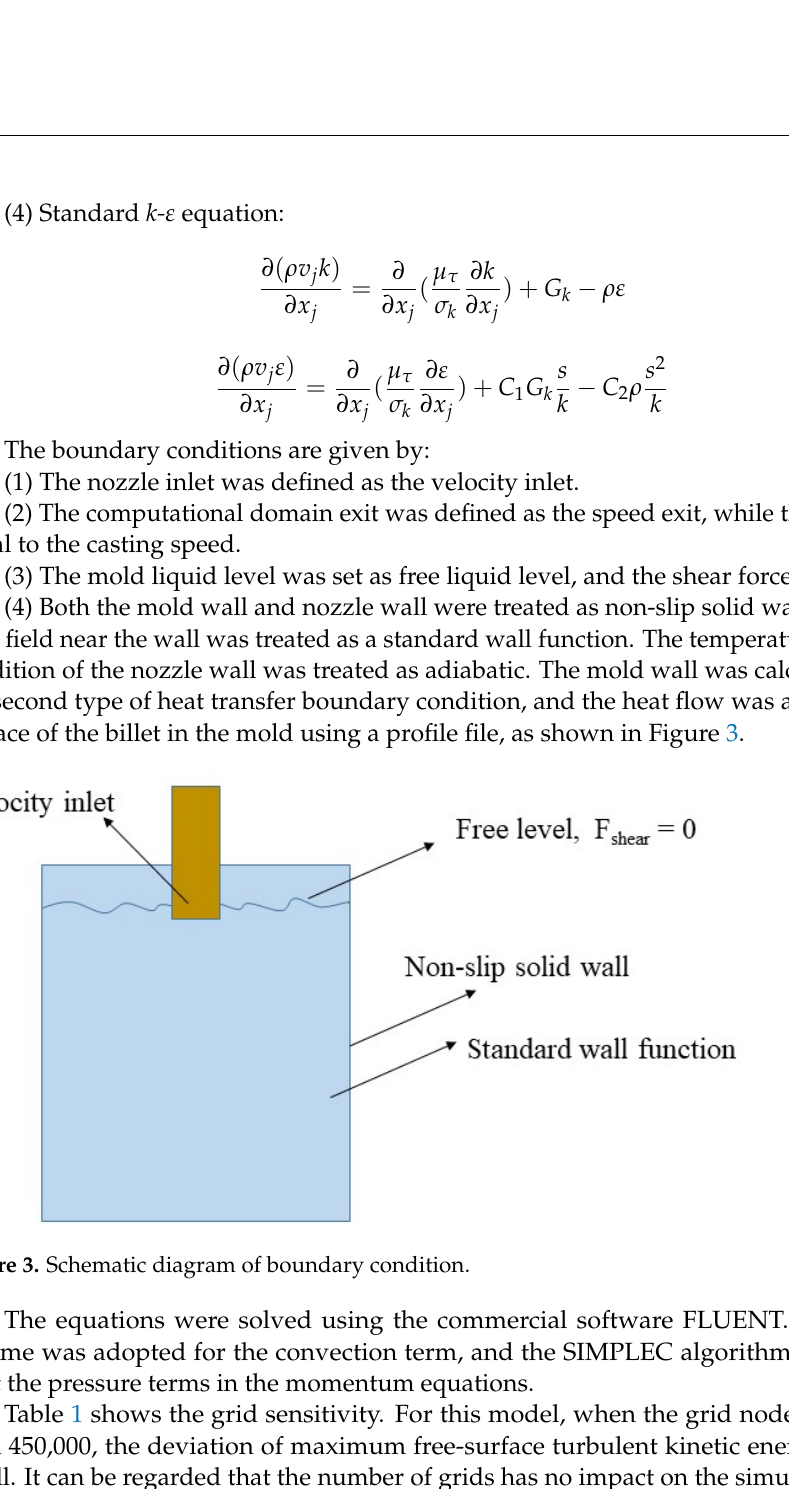
Maximum Free-Surface Turbulent Kinetic Energy